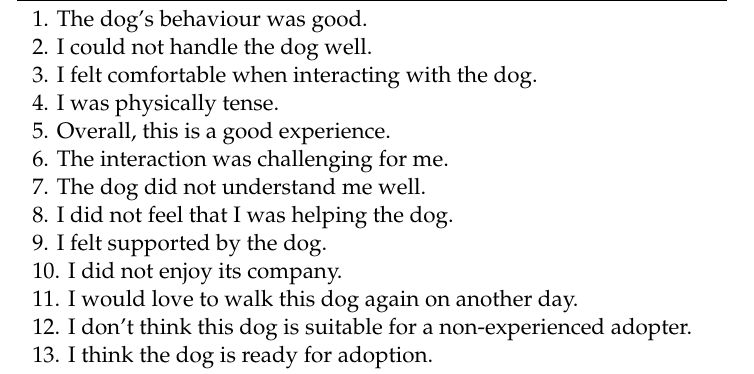
Table 2. Factor loadings for the 13 items in the exit questionnaire.